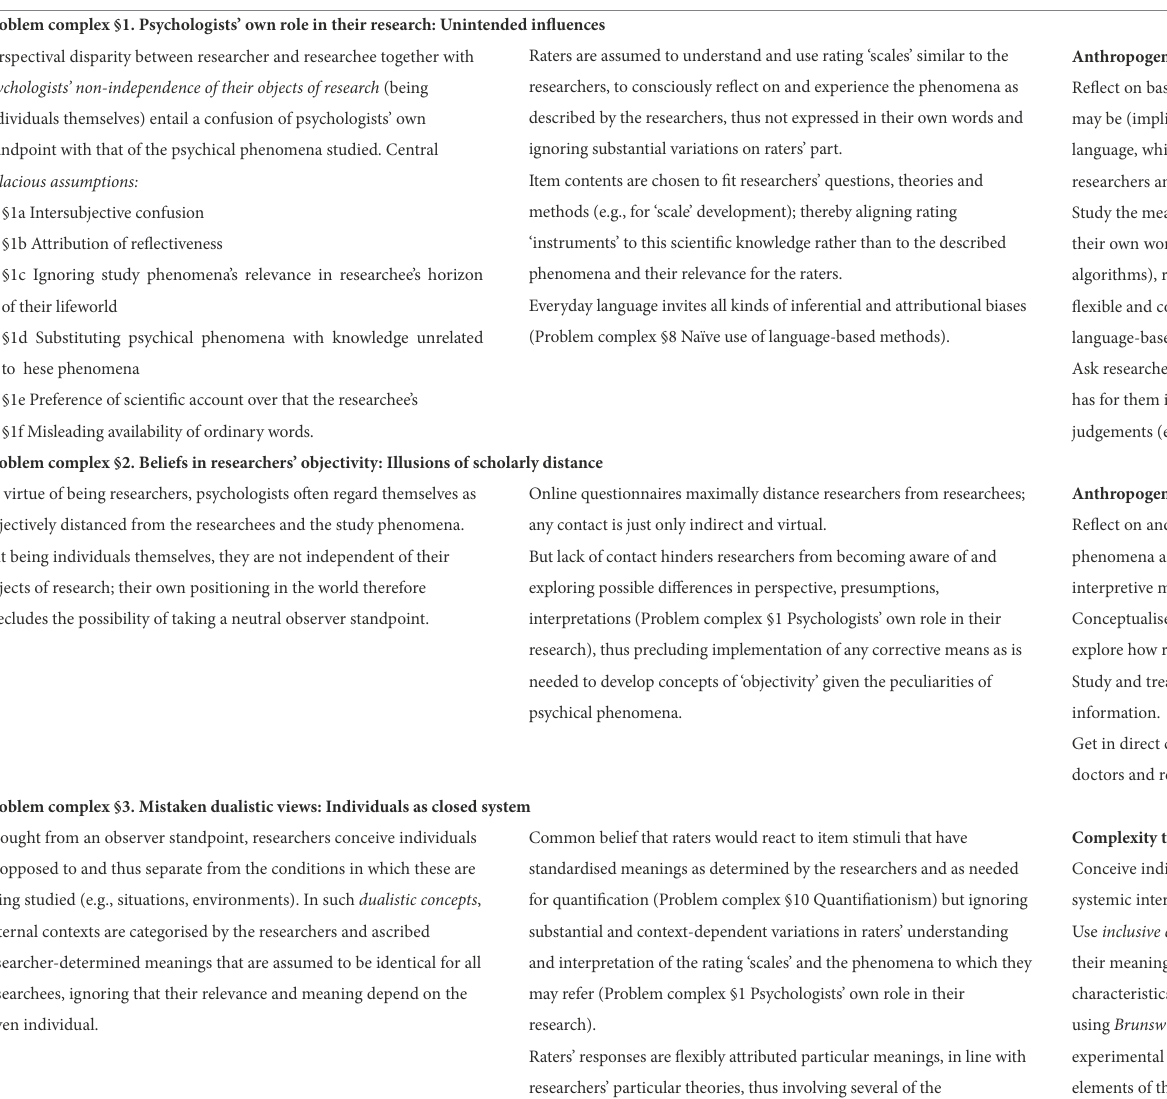
TABLE 2 The 12 problem complexes, their implementation in rating ‘scales’ and derivation of directions for possible